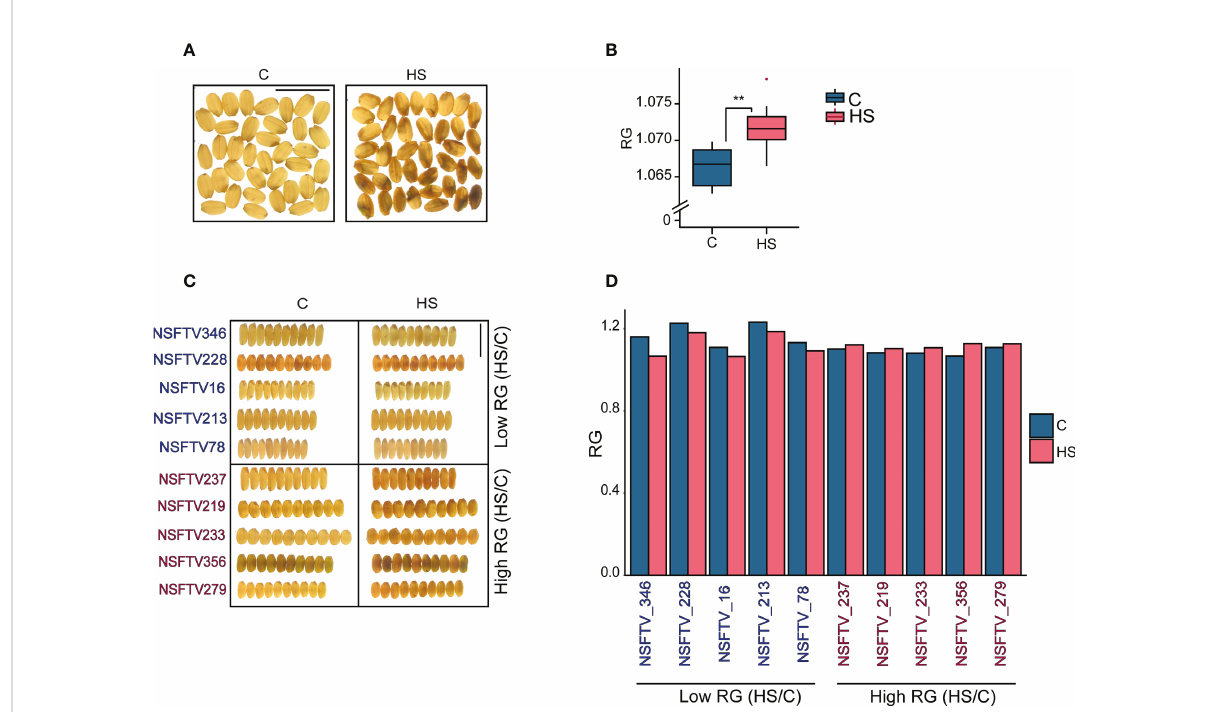
FIGURE 1 Relation between variation in the ratio of grain R and G pixel intensity (RG) values and grain chalkiness in response to heat stress (HS). (A) Light box images of control and HS-treated rice (cv. Kitaake) grains showing the difference in grain chalkiness. (B) RG values of control and HS- treated grains (C) Light-box images of 10 selected RDP1 accessions with a lower and higher percentage change for RG (HS/Control) (D) RG values of grains shown in (C) C and HS indicate control and heat stress, respectively. ** indicates the signi fi cance of a t-test with P <0.05. Scale